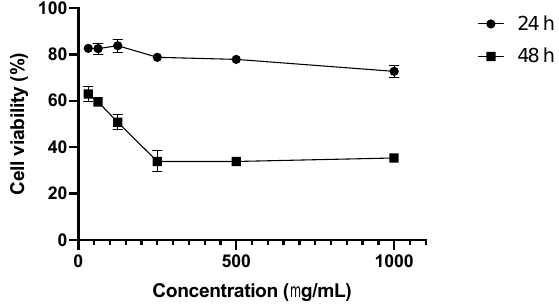
Figure 2. Profile of red ginger extract cytotoxicity on WiDr cells by MTT method. WiDr cells were plated on 96 well-plates then treated with red ginger extract at concentration 15.2, 31.3, 62.5, 125, 250, 500µg/mL for incubation 24 and 48h. Cytotoxicity was expressed by % cell viability shown as mean ± SD.